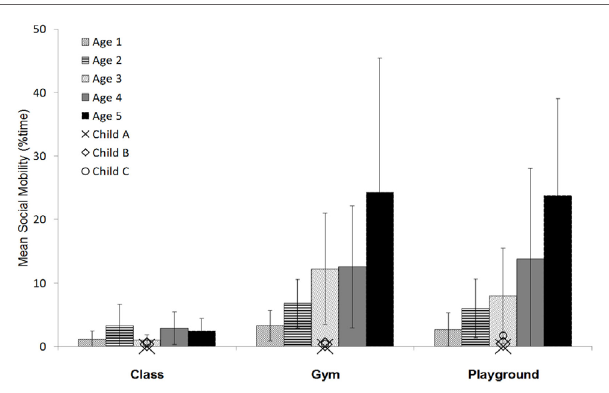
FigUre 1 | comparison of mean social mobility (% time) across 1- to 5-year-old age groups and contexts (classroom, gymnasium, and playground) and in relation to individual disabled children (child a, B, and c) .